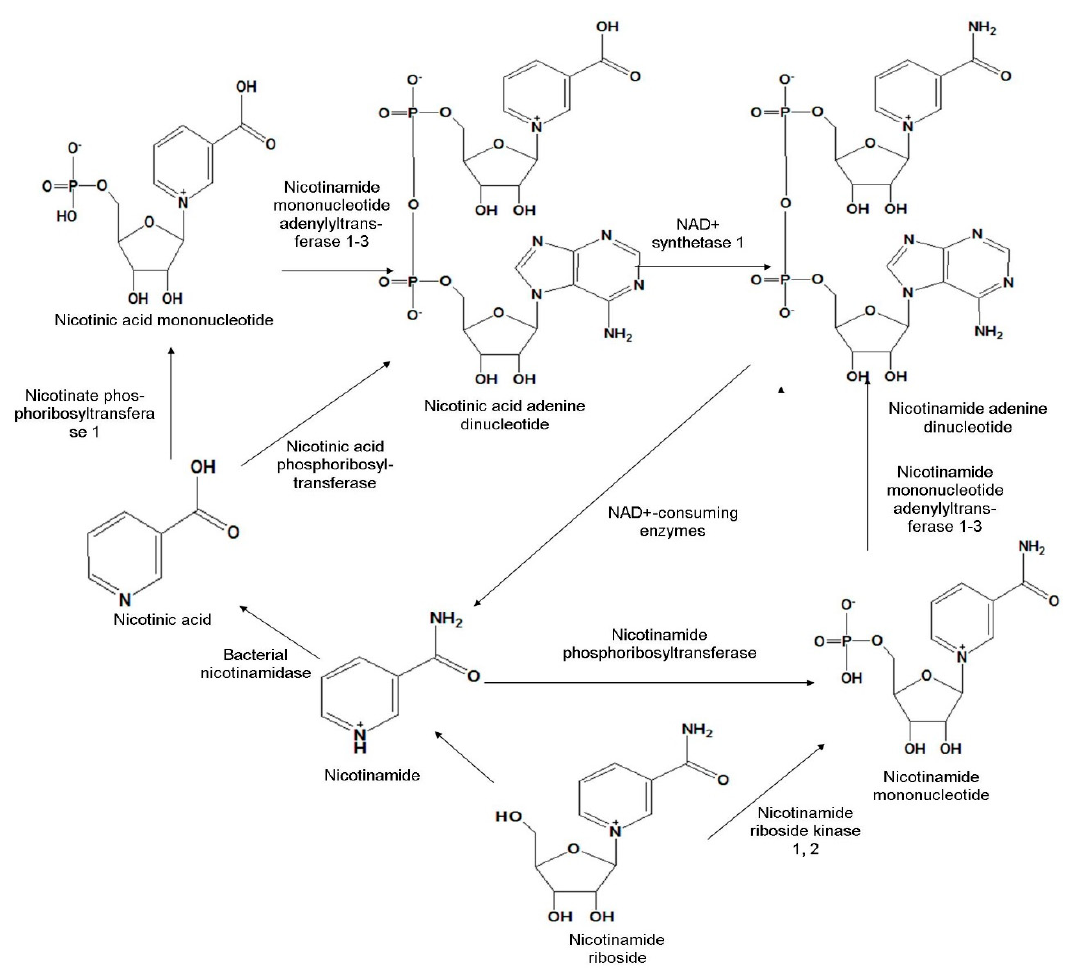
Figure 1. Biosynthetic pathway of nicotinamide mononucleotide in mammalian cells.